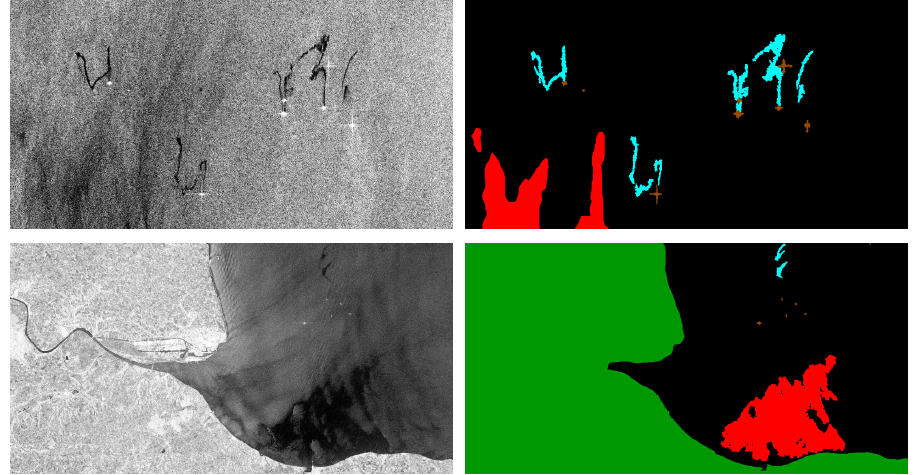
Figure 1. Training dataset: A sample of two Sentinel 1 SAR images ( left ) along with ground truth masks ( right ) and class labels, viz., sea surface (black), oil spill (cyan), lookalikes (red), ship (brown), and land (green). The dataset was prepared by Krestenitis et al. [22] from the MKLab ITI-CERTH, Greece. It comprises validated oil spill records from European Maritime Safety Agency